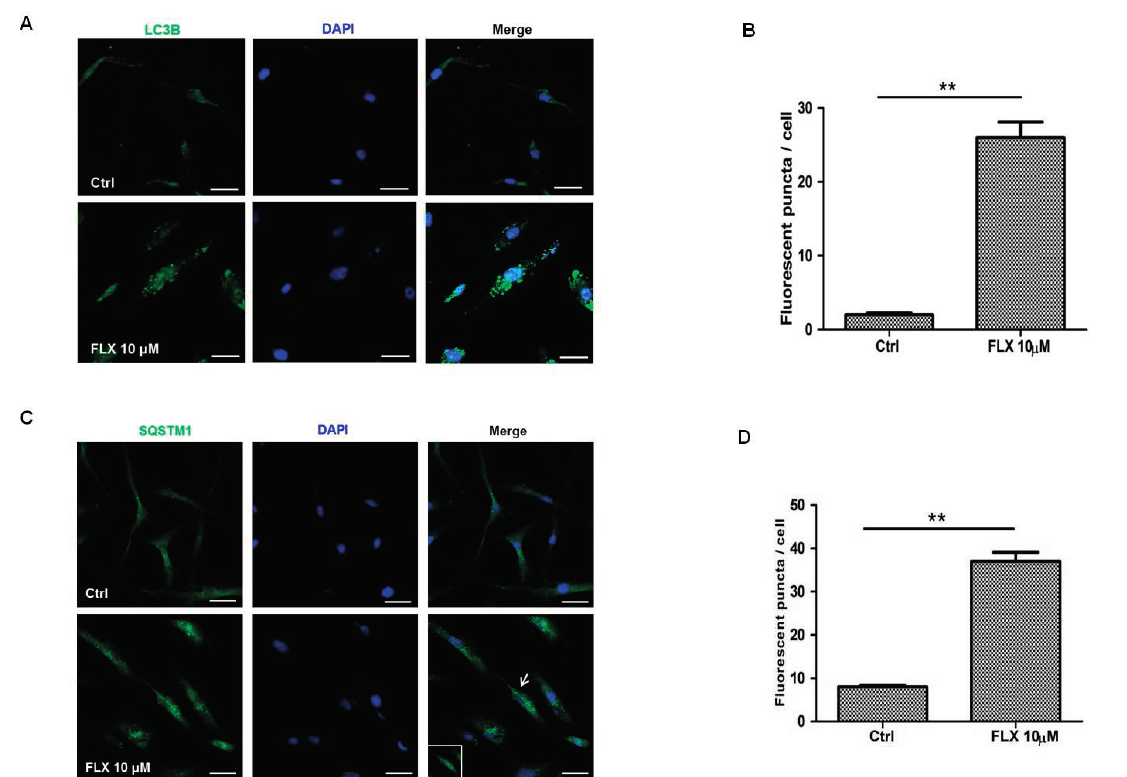
Figure 3. Fluoxetine increased autophagosome formation in ASCs. ( A ) Punctate expression of LC3B (Santa Cruz Biotech, sc-28266) is common feature of autophagy, Scale bars = 20 μ m; ( B ) Fluorescence puncta number was measured, and fluoxetine significantly increased the punctate fluorescence signal in ASCs; ( C ) Although punctate expression of SQSTM1 (arrow, Santa Cruz Biotech, sc-28359) is not as clear as that of LC3B, SQSTM1 staining also formed punctate-like structures. Scale bar = 20 μ m; ( D ) Fluorescence puncta number was measured, and fluoxetine significantly increased the fluorescence signal of SQSTM1 in ASCs. All values are presented as a mean ± STD ( n = 3). ** p <